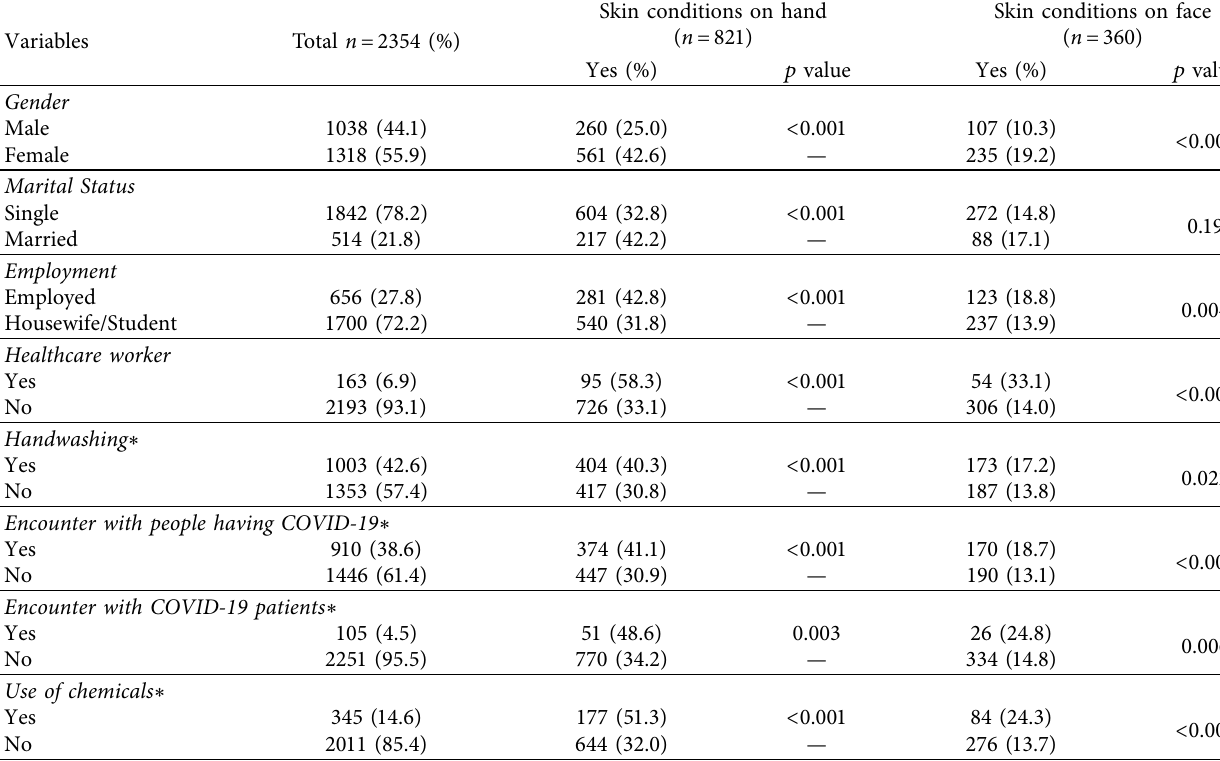
Table 1: Sociodemographics and hand hygiene practices during the COVID-19 pandemic, and the prevalence of skin conditions ( n � 2354).